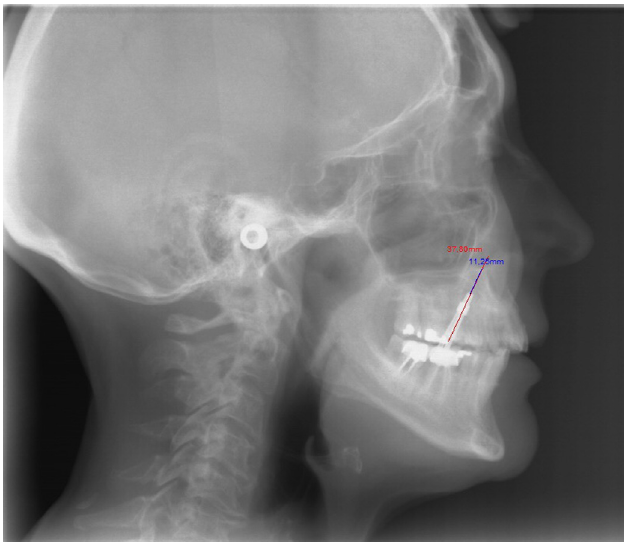
Fig. 3. Lateral teleradiography of pro fi le, surgical guide in place.